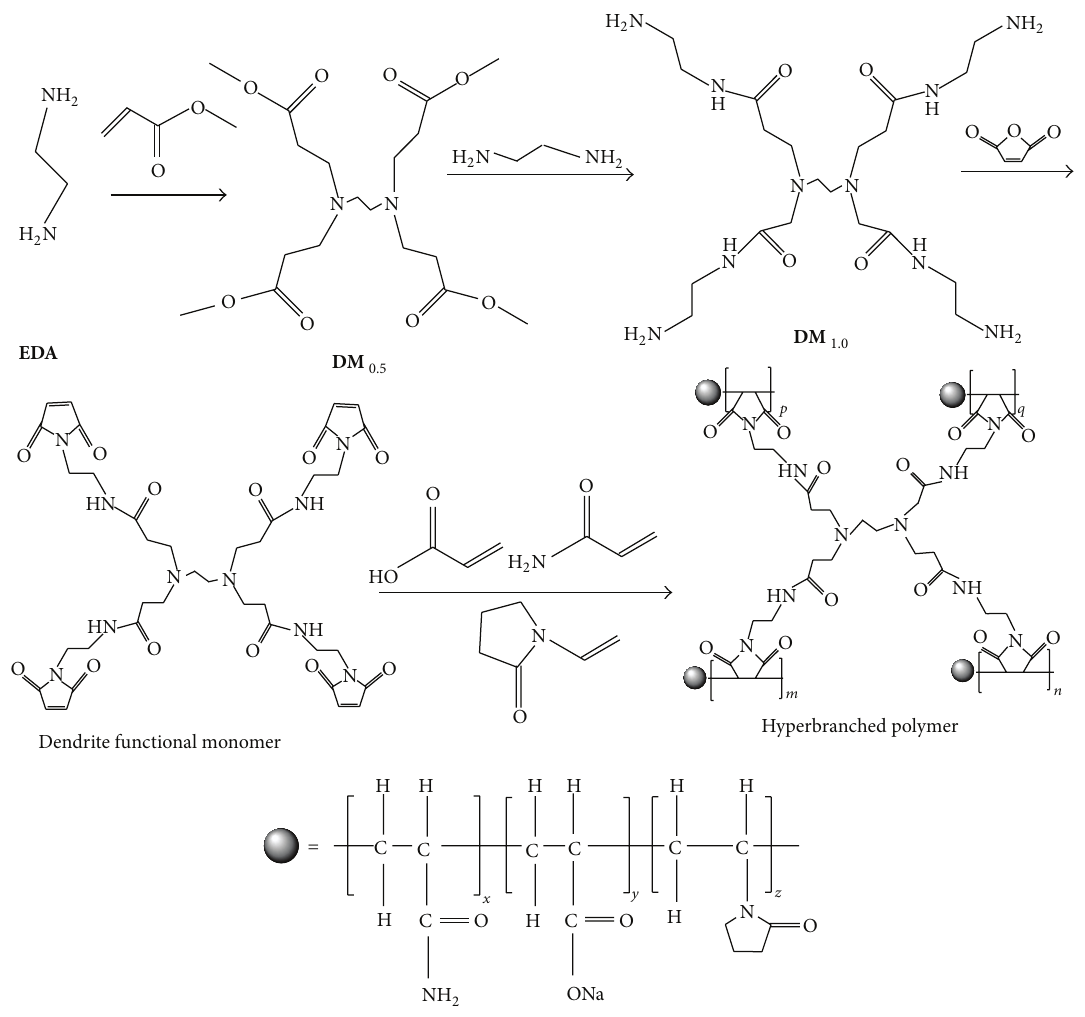
Scheme 1: The synthesis route of the hyperbranched